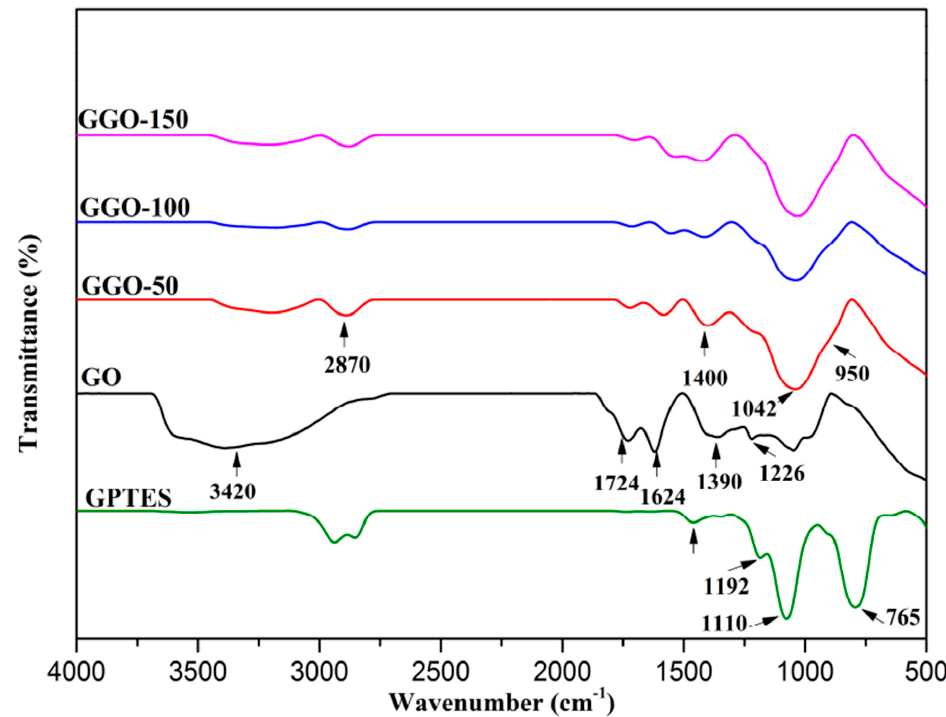
Figure 3. FTIR spectra of GO and 3-glycidyloxypropyltrimethoxysilane functionalized-GO (GGO-50, GGO-100 and GGO-150).